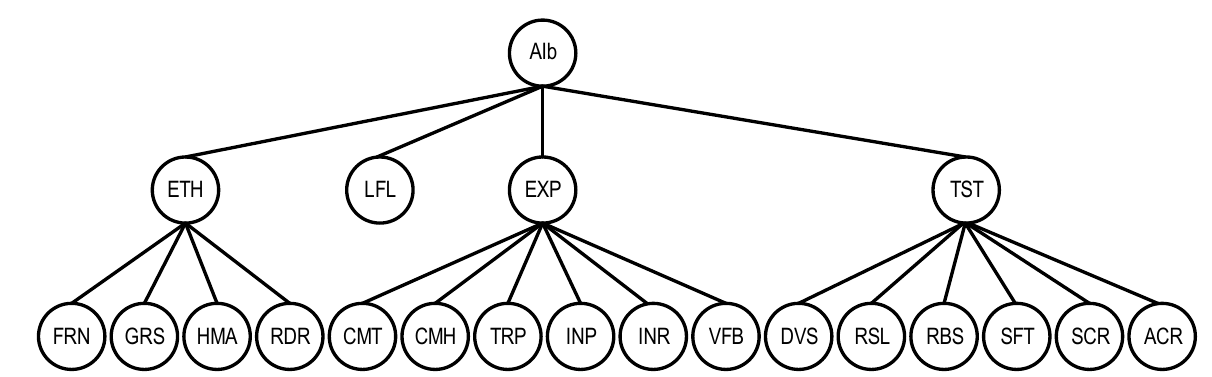
Figure 7. The graph representation of the basic AI quality model 𝑄𝑆 𝐶ℎ𝐴𝐼𝑏 .